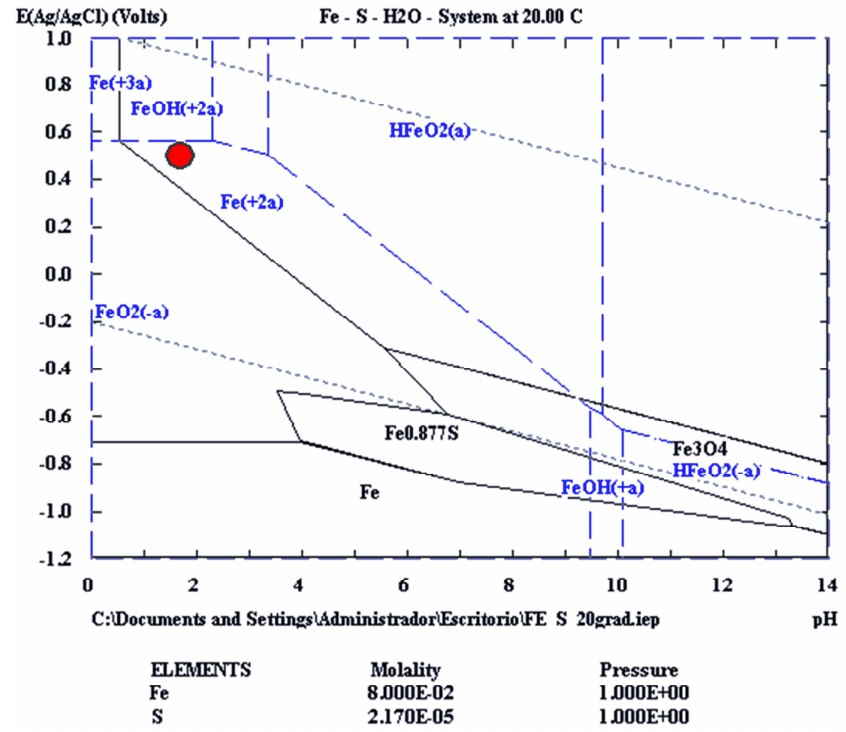
Figure 4. Predominance diagram zones at a total iron concentration of 8.00 × 10 − 2 M, total sulfur concentration of 2.17 × 10 − 5 M, and total pressure of 1 atm.